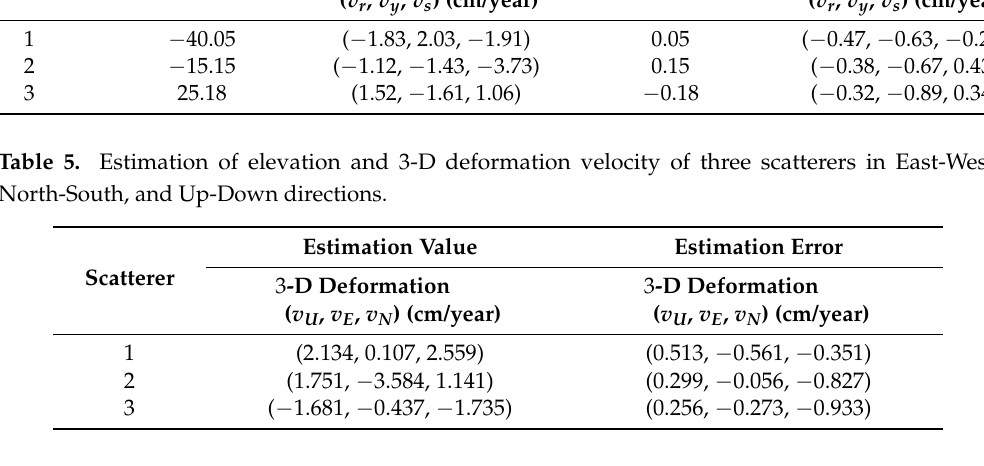
azimuth, and elevation directions.